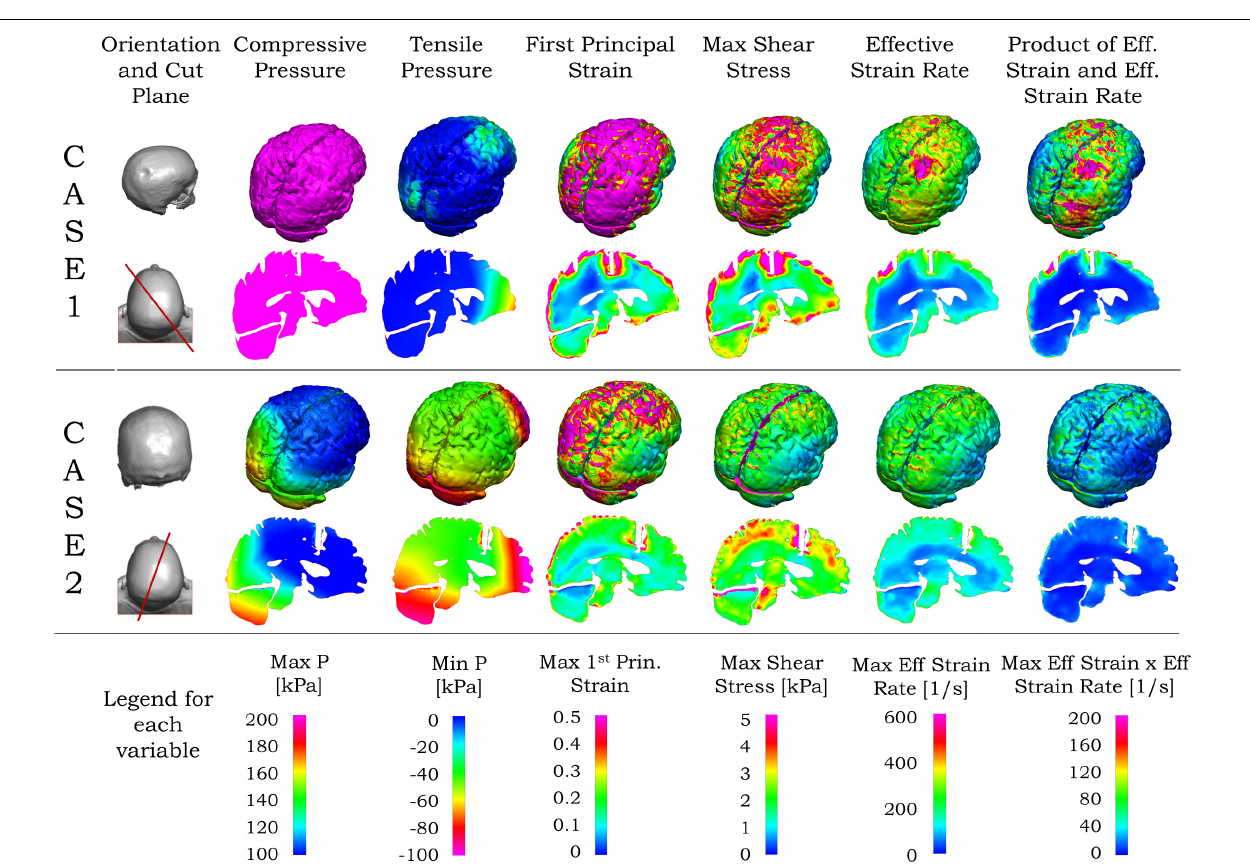
case 1, when the angular velocity is varied between 28 and 32 rad/s, the skull indentation changes from 8.6 to 9.5 mm and the head acceleration from 245 to 290 g. The region of